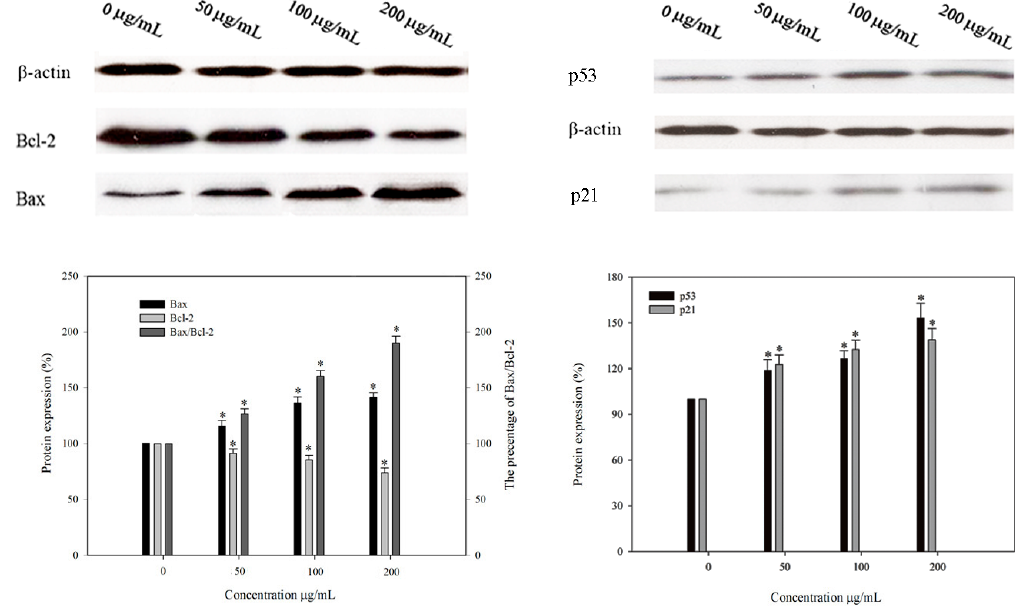
Figure 8. Effects of B. exarata polysaccharide-protein complex BEPS-IA on the expression of p53, p21, Bcl-2 and Bax proteins associated with cell cycle and apoptosis in HepG2 cells. Western blot analysis was performed in triplicate per experimental point, and the relative expression of protein was quantified densitometrically (%); β -actin was used as reference control. Values marked with * are significantly different compared to the control ( p < 0.05).